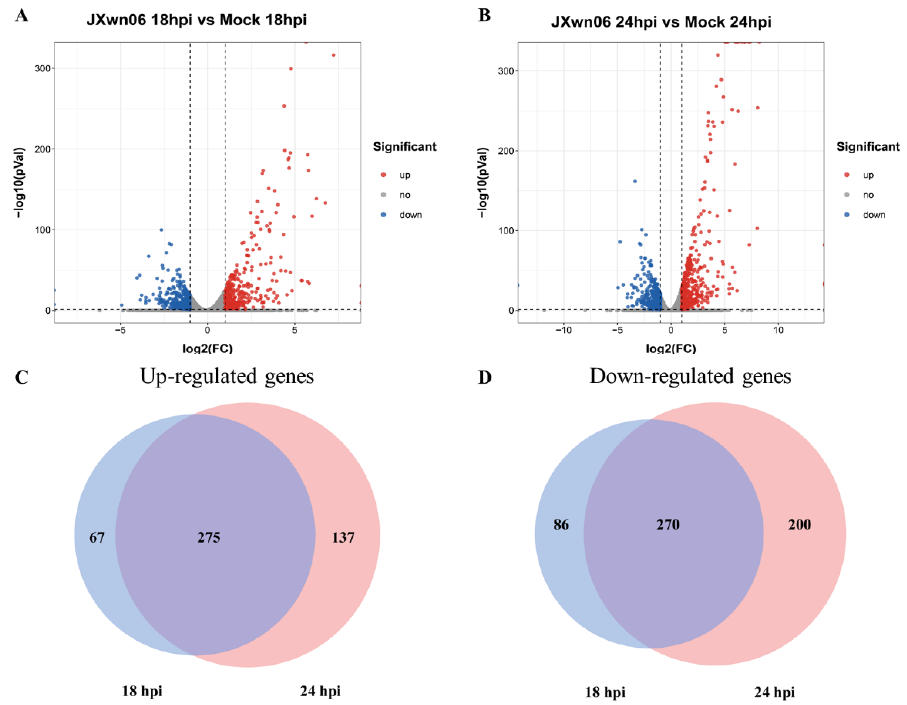
Figure 2. Differentially expressed genes (DEGs) in PMVECs co-cultured with HP-PRRSV strain JXwn06-infected PAMs. In RNA-seq analysis, three independent experiments were repeated in each group. ( A , B ) Volcano map of a distinguishable mRNA expression profiling in PMVECs after JXwn06 inoculation at 18 and 24 hpi, respectively. The differentially expressed genes were selected with log2 (fold change) > 1 or log2 (fold change) < − 1 and with statistical significance ( p value < 0.05) by R package. ( C , D ) Veen analysis was performed to identified genes co ‐ regulated by JXwn06 at 18 hpi and 24 hpi, including 275 co ‐ upregulated ( C ) and 270 co ‐ downregulated ( D ) genes. Data were extracted from RNA ‐ seq results.